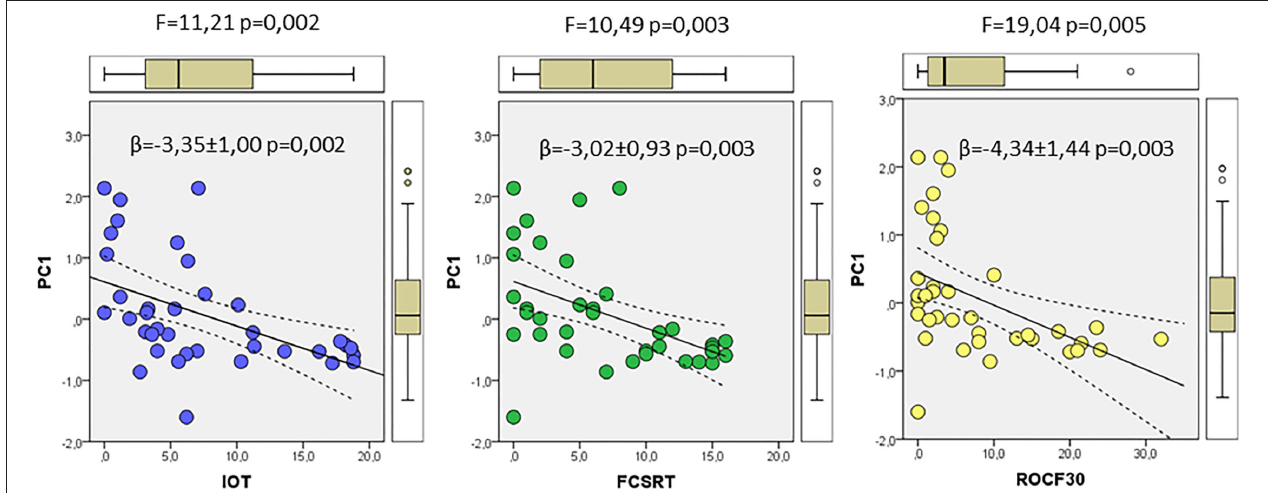
FIGURE 7 | The associations of neurocognitive tests and multivariate outcomes shown in Figure 6 . The linear relationships between PC1 as dependent variable and in–out (left), FCSRT (middle), and ROCF30 (right) tests as independent variables along the whole range of data are shown. The regression lines are represented along with the corresponding 95% confidence intervals and individual box-plots, in each analysis. The regression coefficients ( β ) and significance of regression models are indicated in each panel.